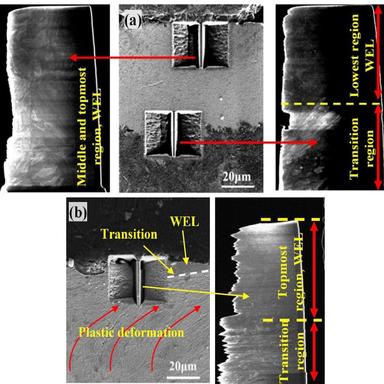
Ion Beam Thinned lamellas obtained from WEL of (a) rail sample A, (b) rail sample B.